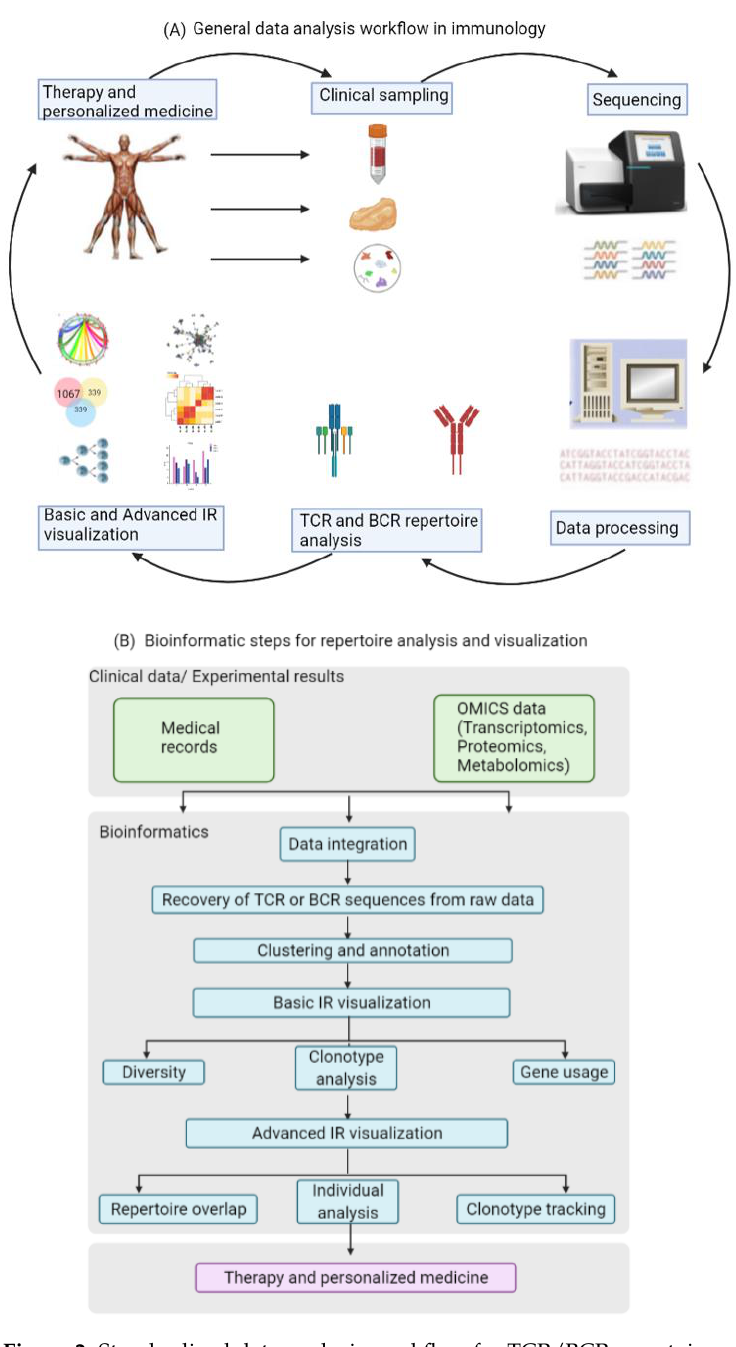
Figure 2. Standardized data analysis workflow for TCR/BCR repertoire analysis. ( A ) Pipeline from the clinic to the sequencing results. ( B ) Bioinformatic steps for basic and advanced immune repertoire analysis and